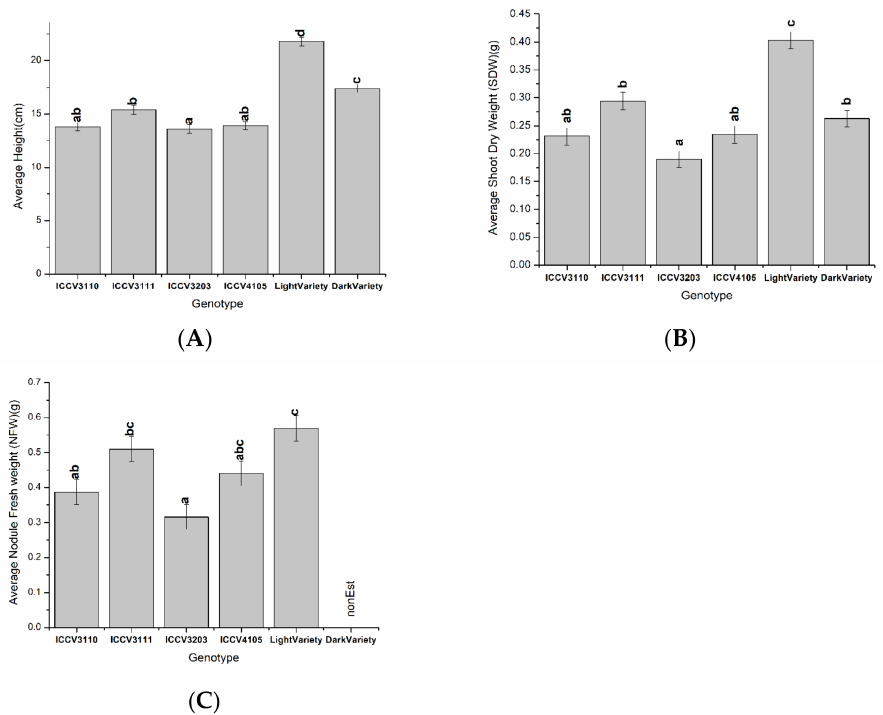
Figure 4. The effects of the factor chickpea genotype on average height ( A ), average shoot dry weight (SDW) ( B ), and average nodule fresh weight (NFW) ( C ). Bars are means ± standard errors, n = 3. Different letters (a–d) above the bars indicate treatments with significant differences ( p <